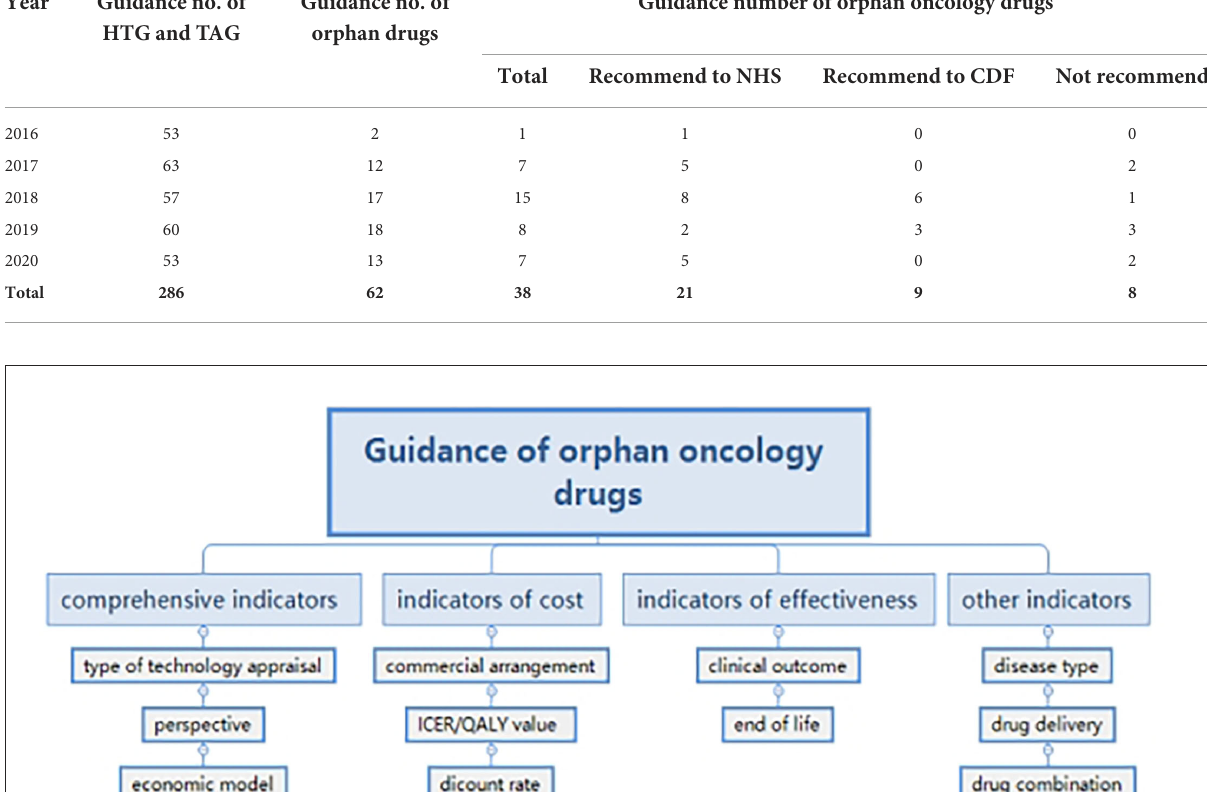
TABLE 1 Orphan oncology drugs guidance from 2016 to 2020.